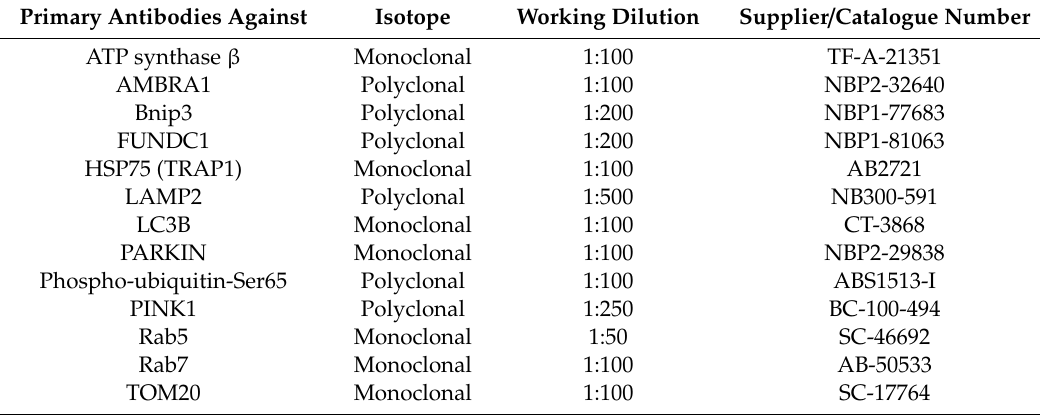
Table 1. List of primary